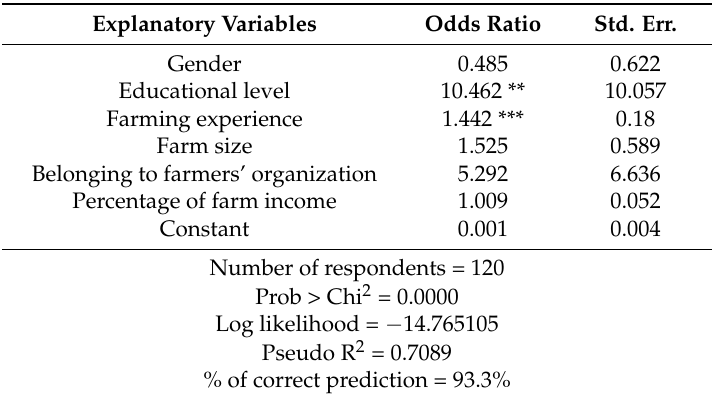
Table 4. Determinants of the decision to adapt to climate change by